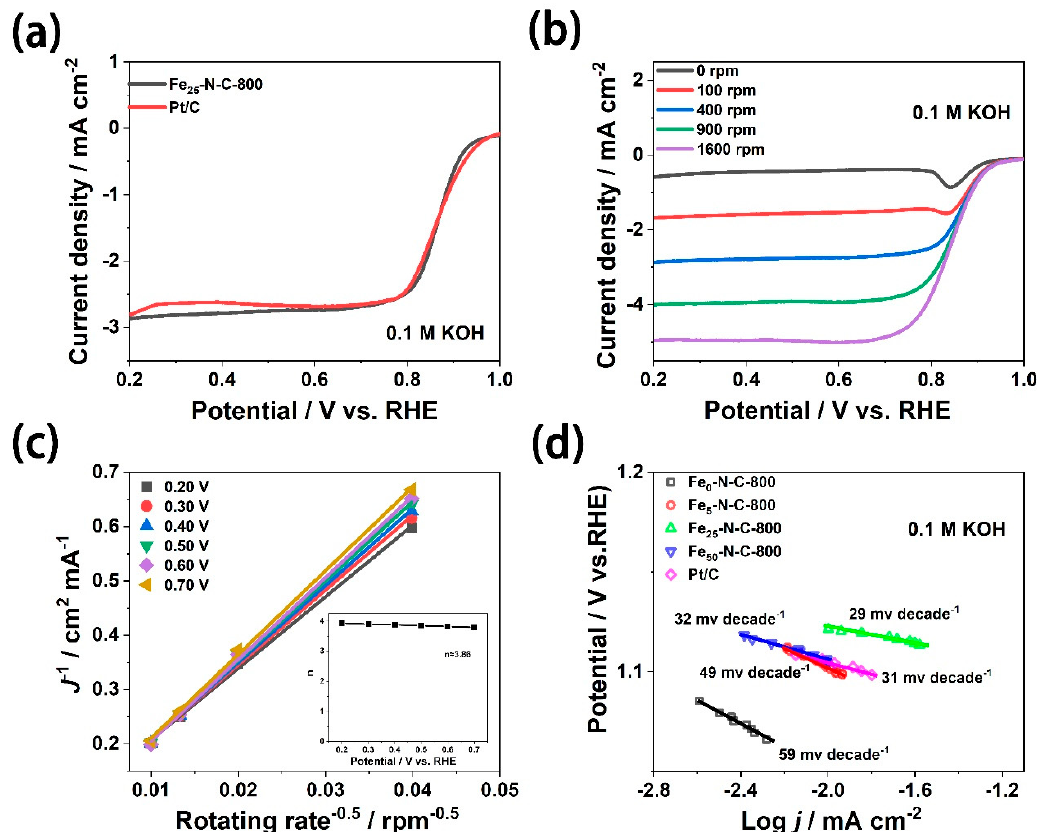
Figure 5. Characterizations of oxygen reduction reaction (ORR) activity in alkaline medium. ( a ) The rotating disk electrode (RDE) dates of Fe25-N-C-800 and Pt/C, rotation rate = 400 rpm. ( b ) Polarization curves of Fe25-N-C-800 at various rotation rates (increasing from top to bottom); ( c ) Koutecky–Levich plots of Fe25-N-C-800 and number of electrons transferred (inset) at various potentials (0.2 –0.7 V vs. RHE); ( d ) Tafel slope plots of Pt/C and FeX-N-C-800 (X = 0, 5, 25, 50 mg) derived from the LSV results.